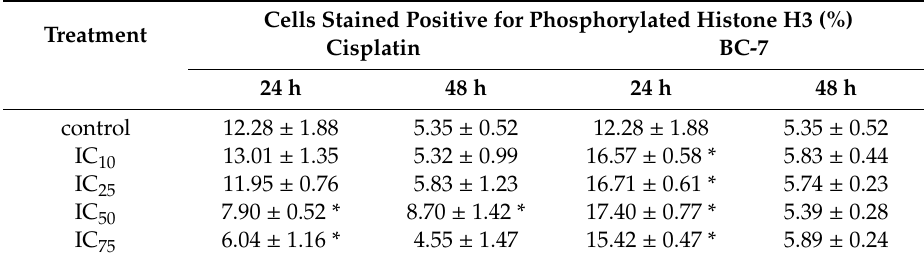
Table 3. Changes in phosphorylated Histone H3 levels in HeLa cells after 24 and 48 h of exposure to BC-7 and